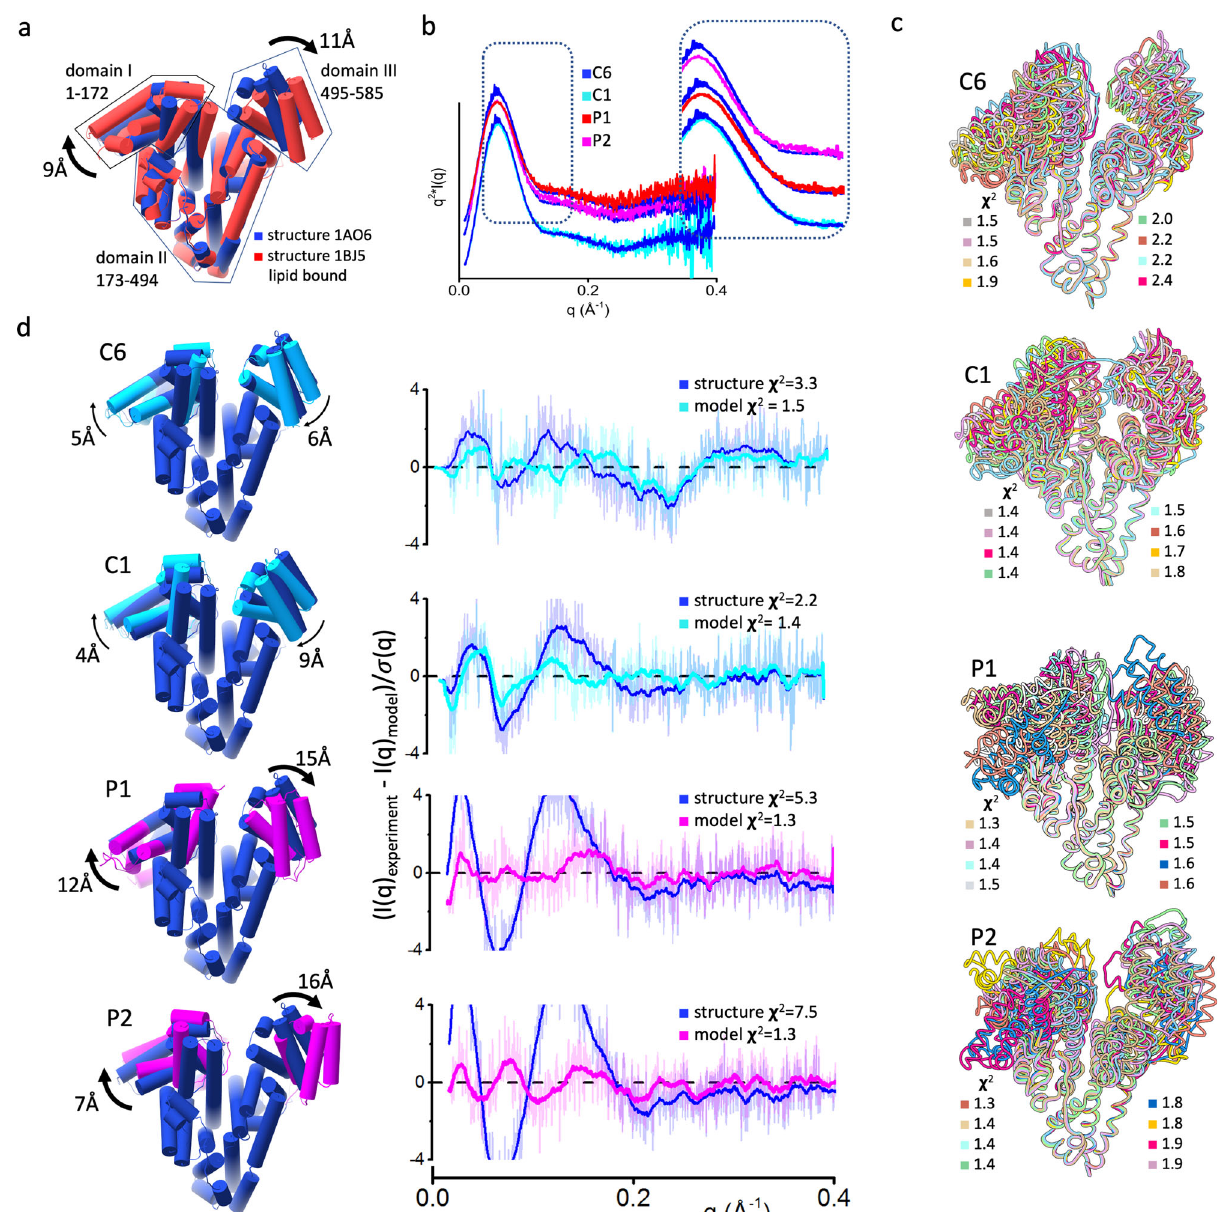
Fig. 3 Patients ’ HSA undergoes a distinct movement of domains I and III. a Superposition of lipid-free (blue) and lipid-bound (red) HSA (PDBID 1AO6 and 1BJ5) crystal structure shows the opening of domains I and III upon lipid binding. b Comparison of Kratky plot for commercial HSA (C6 – blue) with a healthy donor (C1 – cyan) and patients ’ HSA (P1 and P2 – red and magenta) suggest overall structural changes. c Eight top-scoring atomistic models for commercial HSA (C6), healthy donor (C1), and patients ’ HSA (P1 and P2). Atomistic models were superimposed on domain II. The goodness of SAXS fi t ( χ 2) for each model is shown in the fi gure legend with the corresponding color code. d The best fi t atomistic models of commercial HSA (C6 – cyan), a healthy donor (C1 – cyan), and two patients (P1, P2 – magenta) superimposed on to the lipid-free HSA structure (PDBID 1AO6 – blue). The left panel shows residuals and goodness of fi t values ( χ 2 ) between experimental and theoretical SAXS calculated from the atomistic models or lipid-free HSA structure (PDBID 1AO6 –